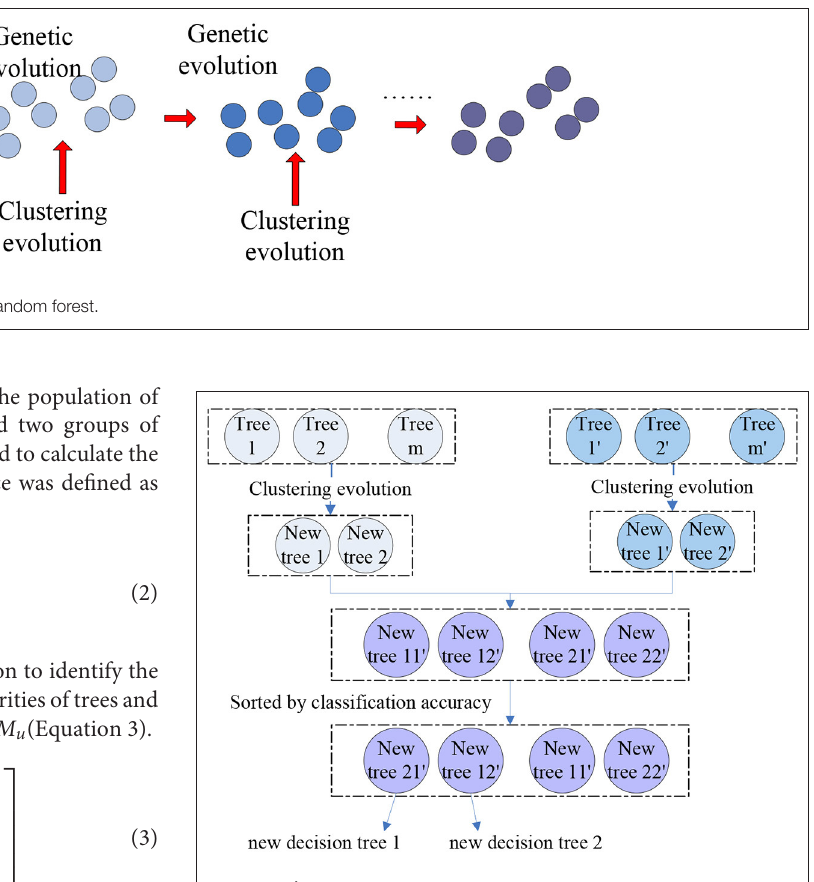
FIGURE 2 | The schematic diagram of the application of clustering evolution in genetic